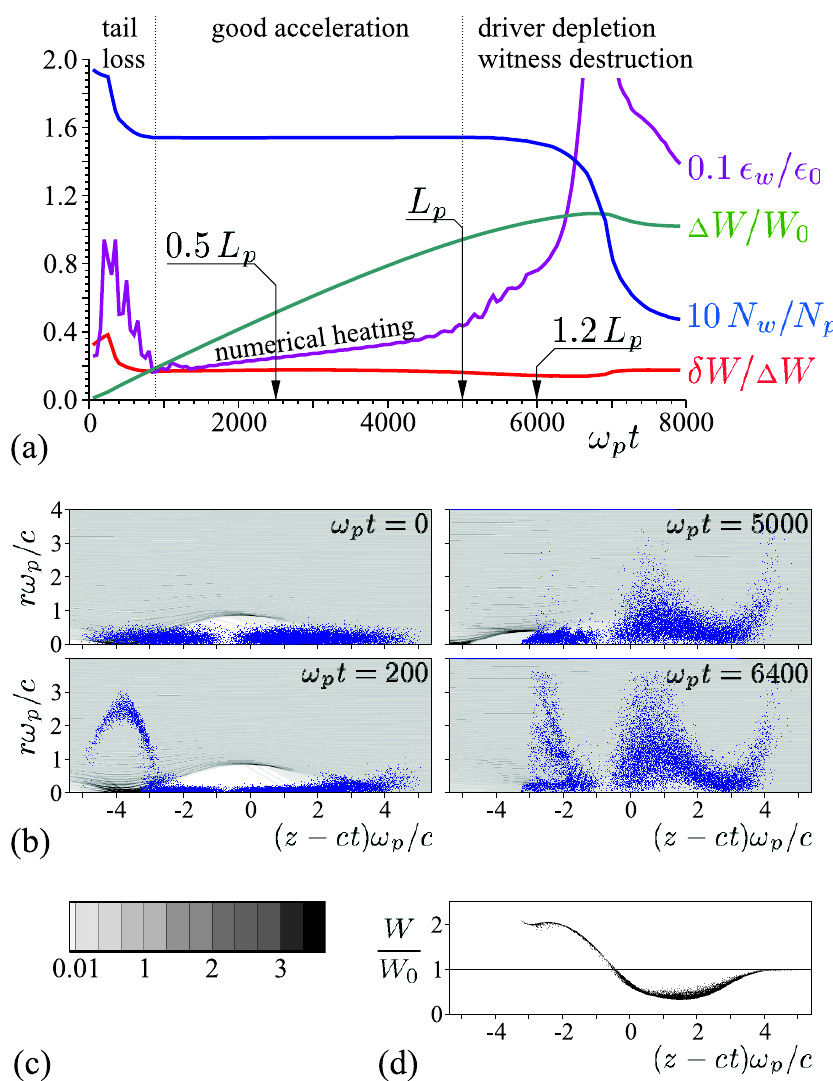
FIG. 3. (Color) (a) Evolution of witness emittance (cid:4) propagates in the plasma; (b) portraits of the beam (dots) and plasma electron density (shading) at different times; (c) the palette for electron density maps; (d) the dependence of the beam energy W on the longitudinal coordinate at the end of good acceleration (at t (cid:1) 5000 ! p